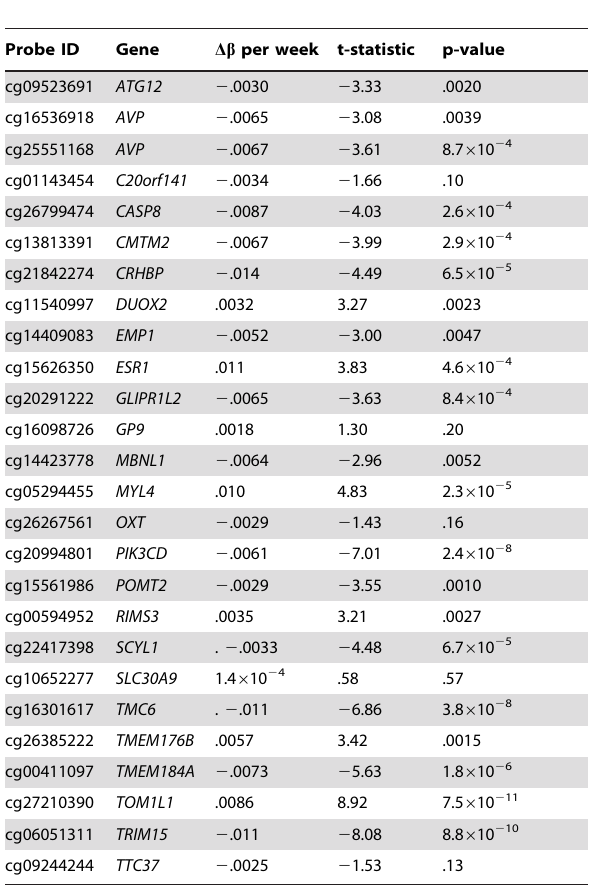
Table 5. Replication of CpG sites previously associated with GA [18].